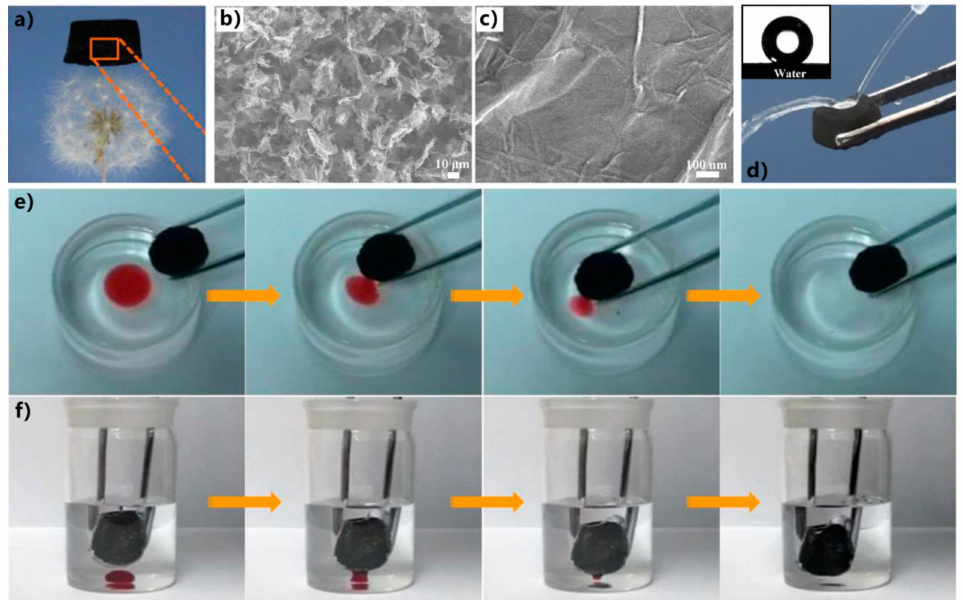
Figure 18. Absorption and removal of oil from water through a superhydrophobic graphene aerogel. ( a ) Photo of a piece of cylindrical aerogel on the top of a dandelion. ( b , c ) Morphology of the graphene aerogel. ( d ) Water flow bouncing off the surface of the aerogel. Inset: water droplet on the superhy- drophobic graphene aerogel. ( e ) Selectively adsorbing oil (toluene) floating on the water surface by the as-prepared graphene aerogel. ( f ) Selectively adsorbing heavy oil (chloroform) underwater by the as-prepared graphene aerogel. Reprinted with permission from ref. [284]. Copyright 2018, American Chemical